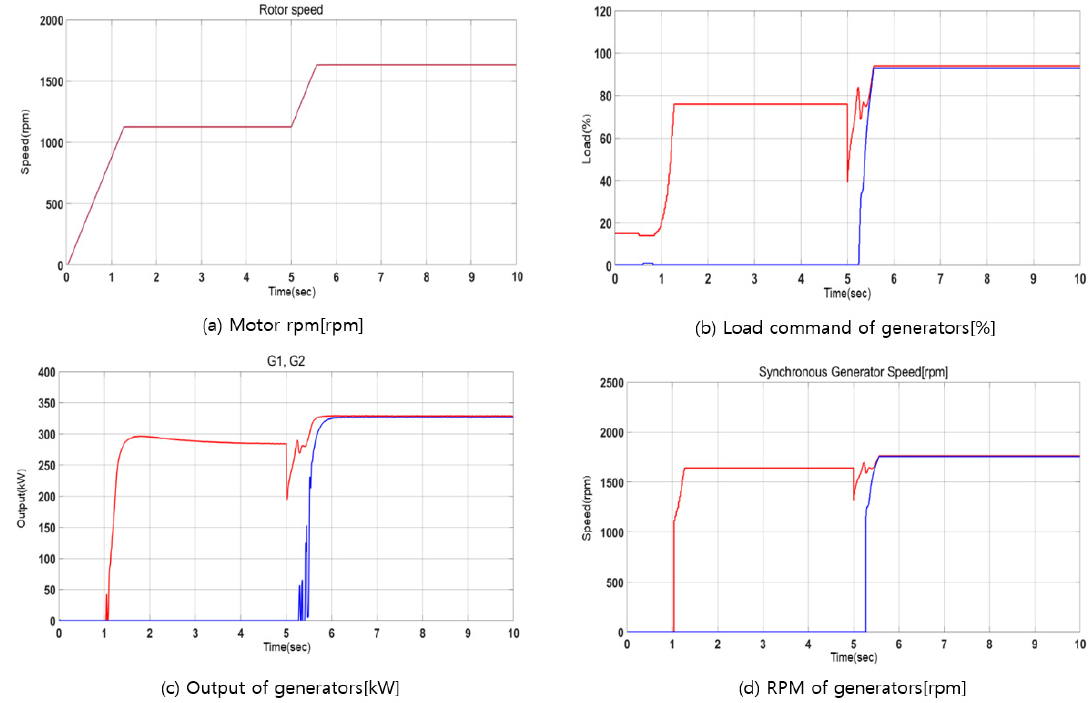
Figure 26. Simulation results of propulsion motor and generators when load varies as 25 → 75%.